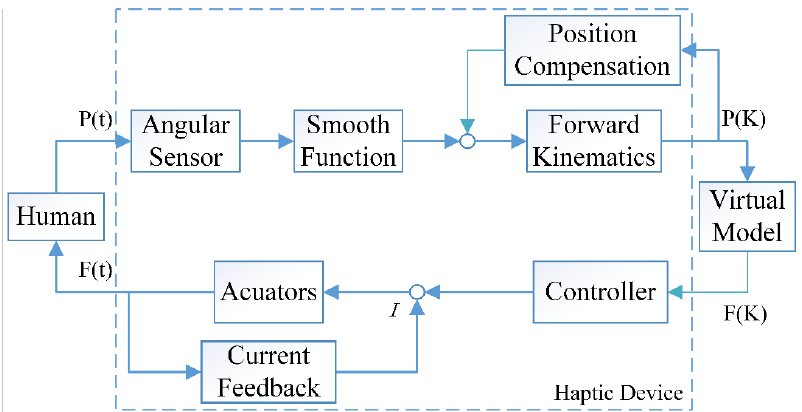
Figure 11. Control scheme diagram.